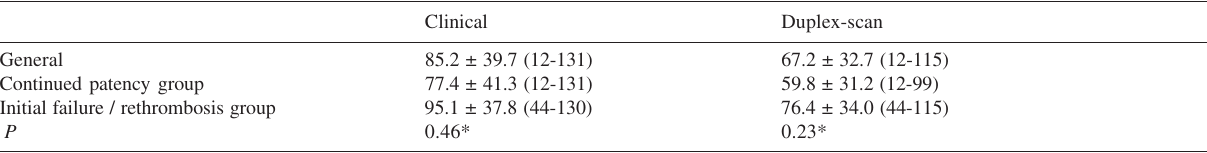
Table 4 - Period of clinical and duplex-scan follow-up (weeks)